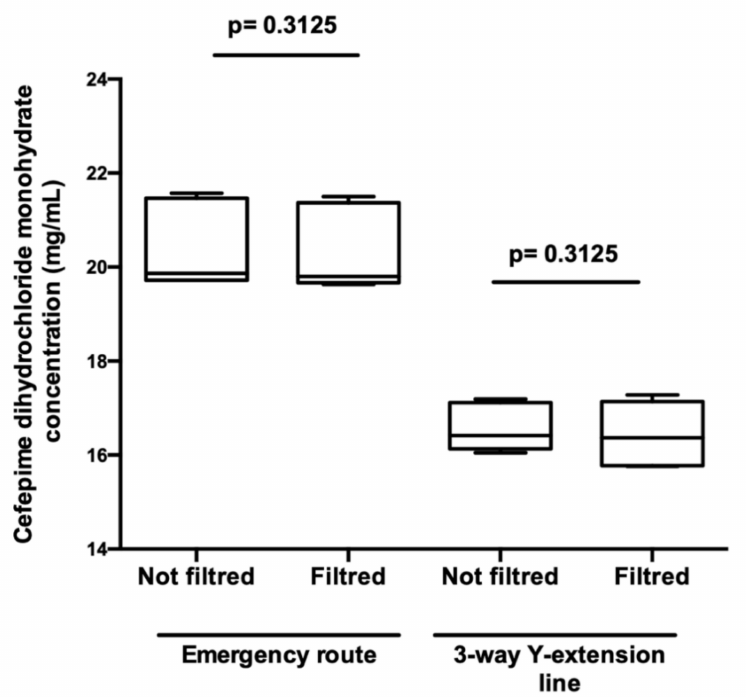
Figure 9. Impact of the filter on cefepime dihydrochloride monohydrate concentration. Comparison of cefepime dihydrochloride monohydrate concentrations between filtered and unfiltered infusion lines: emergency route or 3-way Y-extension line. Results are expressed as medians [min; max] (Wilcoxon, p < 0.05, n =